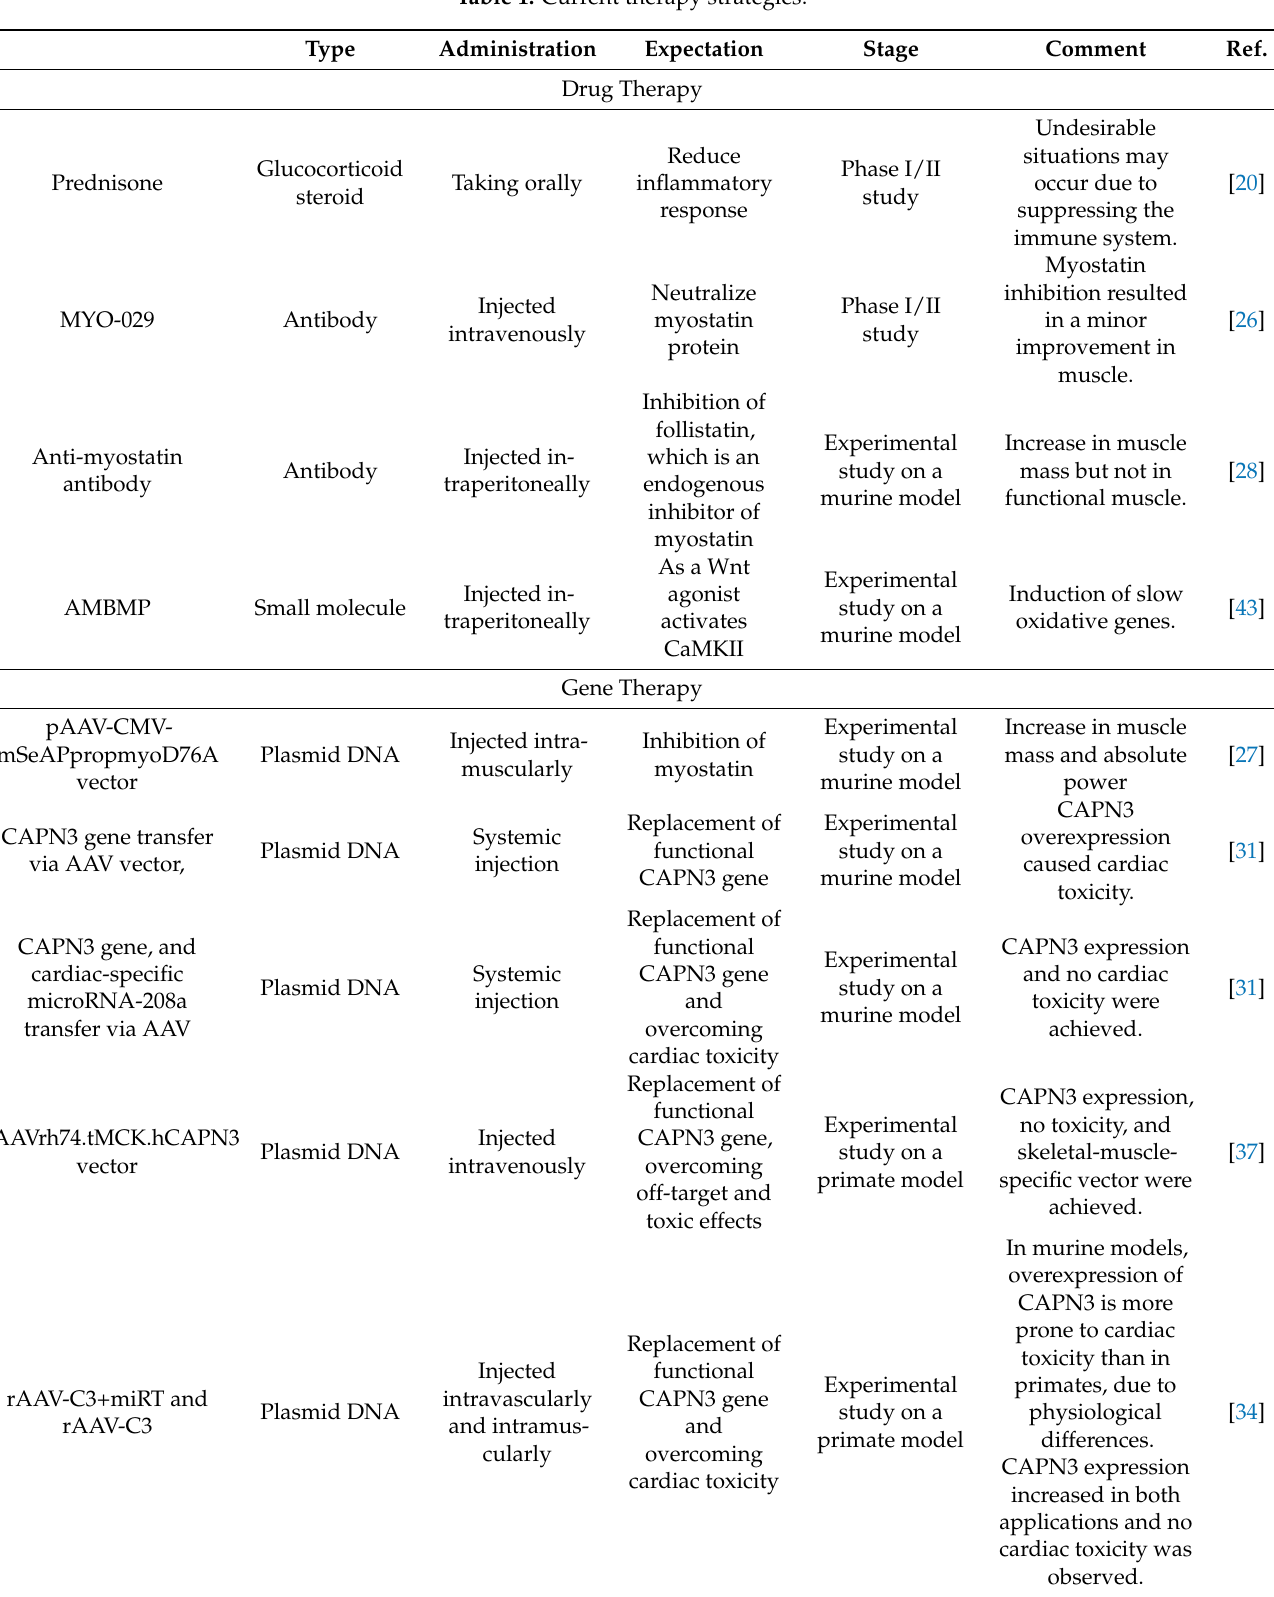
Table 1. Current therapy